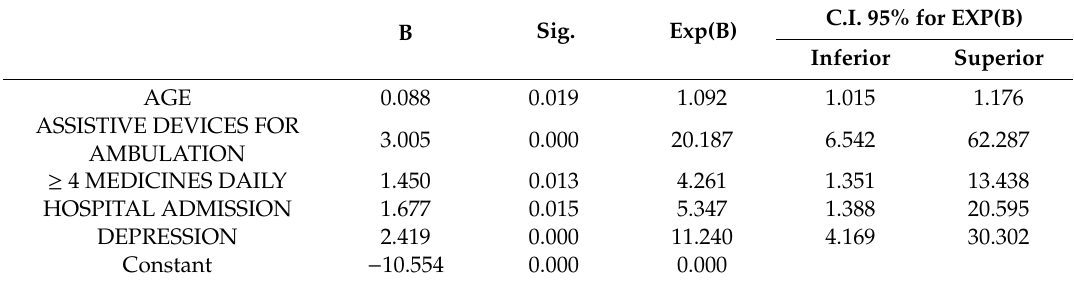
C.I. 95% for EXP(B) Inferior